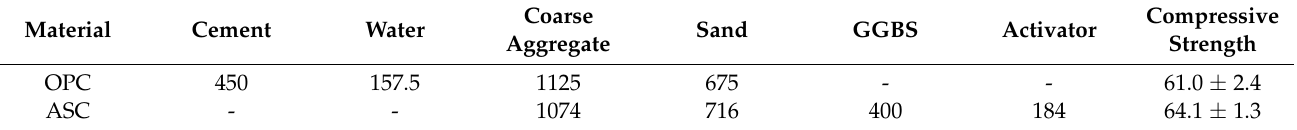
Table 4. Concrete mix proportion (kg/m 3